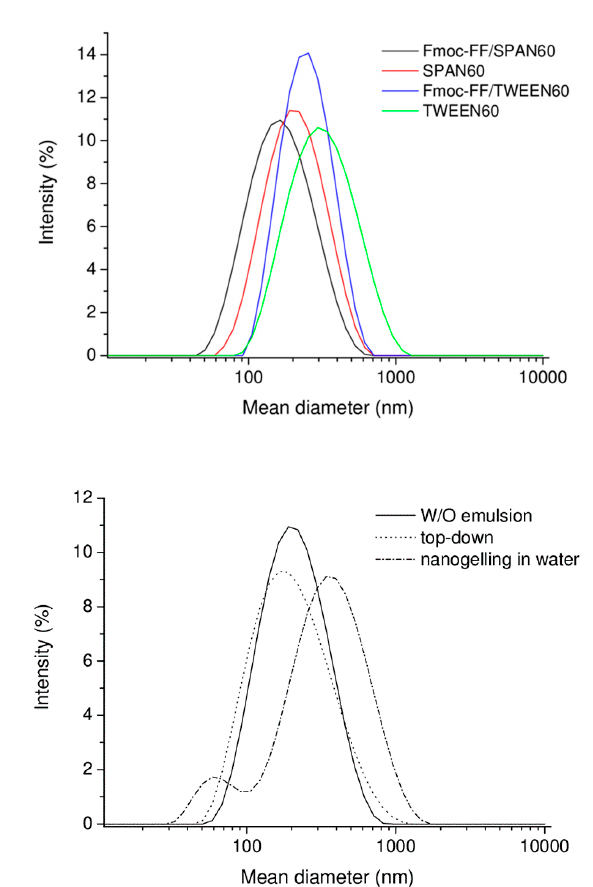
Figure 4. DLS profiles. ( A ) For Fmoc-FF / SPAN ® 60 (HLB = 4.7) and Fmoc-FF / TWEEN ® 60 (HLB = 14.9) as compared with the corresponding aggregates lacking the dipeptide; ( B ) For Fmoc-FF nanogels prepared according to W / O emulsion, top-down, and nanogelling in water methods (HLB =